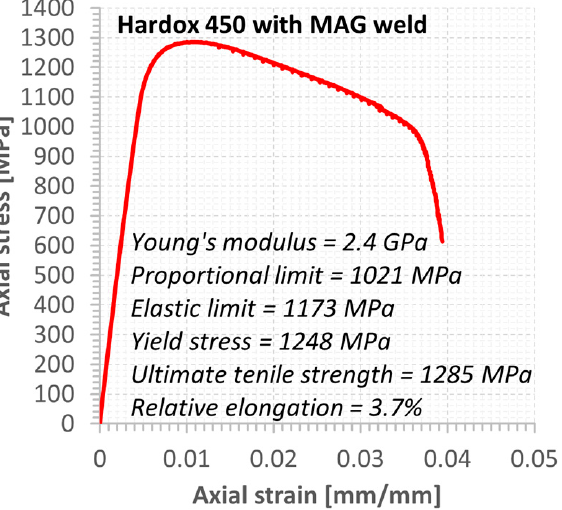
Figure 6. Tensile characteristics and mechanical parameters of the Hardox 450 MAG weld.